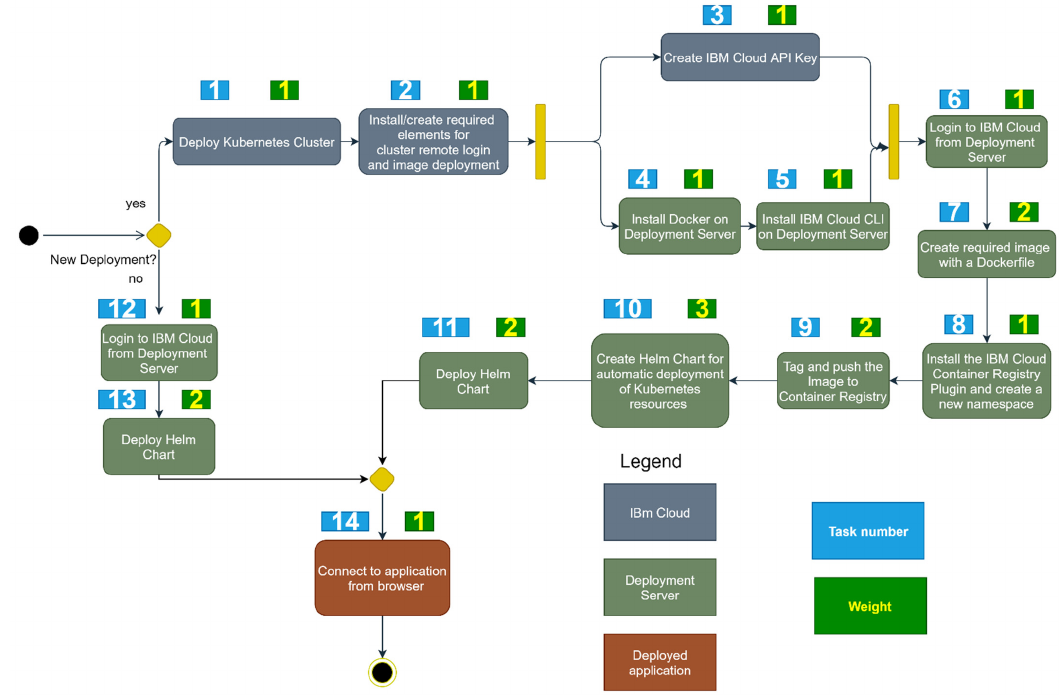
Figure 3. The weighted manual deployment process.